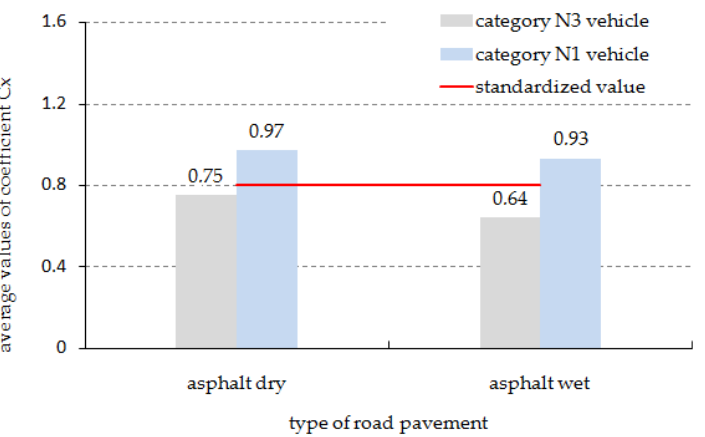
Figure 9. Average values of coefficient C (cid:2934) Cx established for fully developed deceleration values during braking tests performed with an initial speed of 50km/h.